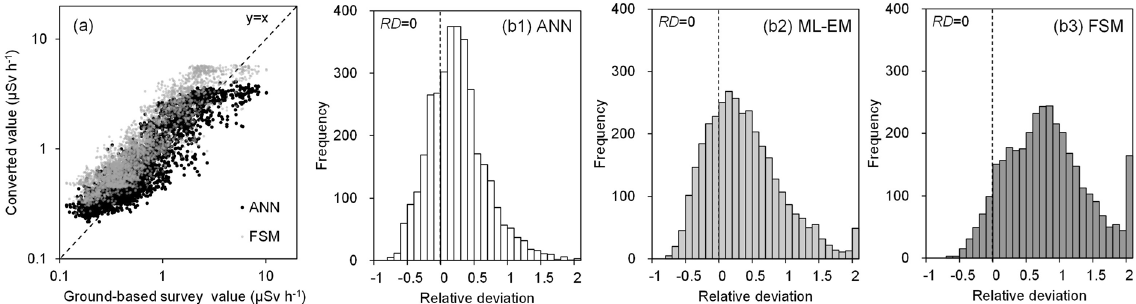
Figure 8. Comparison of the ground-based survey values and the three types of converted values (i.e., ANN, ML-EM, and FSM): ( a ) scatter diagrams of the ground-based survey value and the ANN and FSM values in the same location; and ( b ) histograms of the RDs (i.e., ANN, ML-EM, and FSM).